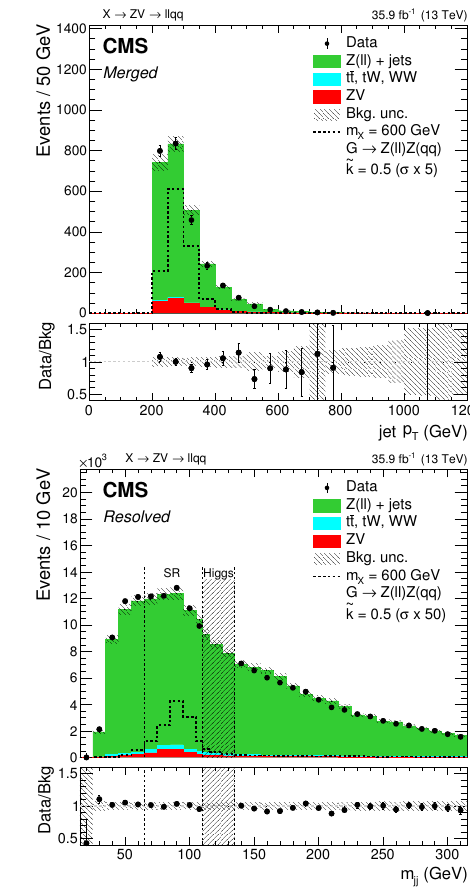
Figure 1 . Upper row: distribution of the merged V candidate (cid:28) 21 (left), where the (cid:28) 21 < 0 : 4 requirement has been removed, and the jet p T (right) in data and simulation for events in the signal region of the low-mass analysis. Lower row: V candidate m j (left) and m jj (right) in data and simulation for events in the signal regions of the low-mass search. The points show the data while the (cid:12)lled histograms show the background contributions. The gray band shows the statistical and systematic uncertainties in the background, while the dashed vertical region (\Higgs") shows the expected SM Higgs boson mass range, which is excluded from this analysis. A 600 GeV bulk graviton signal prediction is represented by the black dashed histogram; for visibility, the signal cross-section is increased by a factor of 5 in the merged category and 50 in the resolved category. With the exception of the jet p T , which typically peaks at approximately half of the resonance mass, the quantities shown have minimal dependence on the mass of the resonance. The